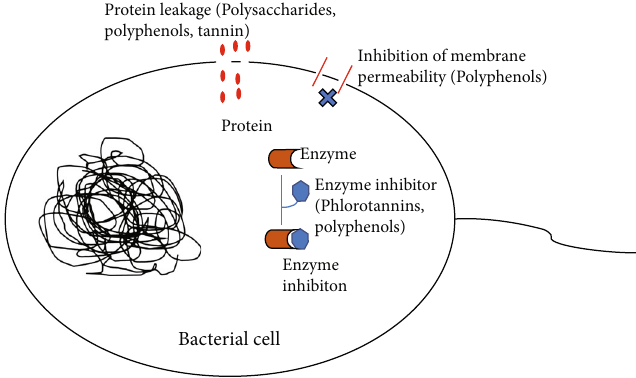
Figure 2: Antibacterial activity of compounds of brown